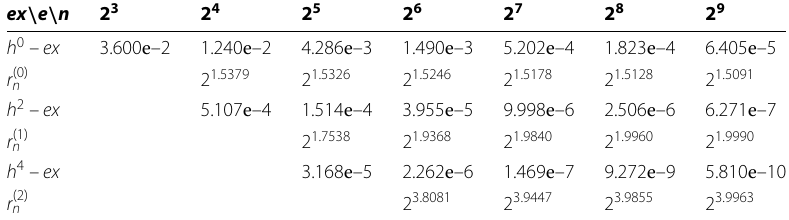
Table 4 The numerical results for t =